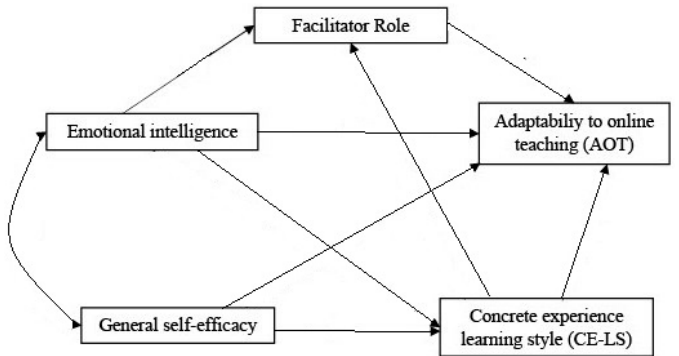
Figure 1. Proposed multiple mediation model. Hypothesis 4 (H4). The multiple-mediation model that includes the direct effect of EI and general self-efficacy of AOT, as well as indirect effects via the teacher’s Facilitator role, respectively, CE-LM, has a good fit with the